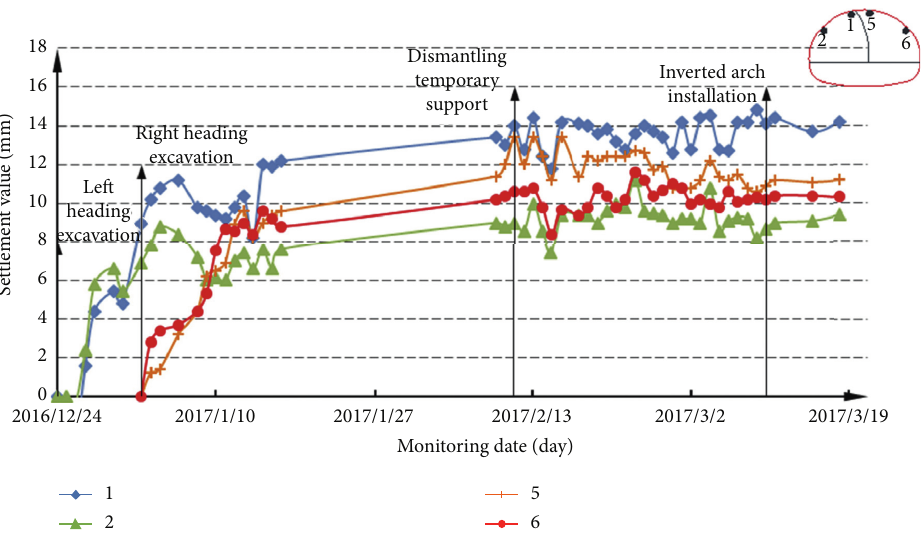
Figure 6: The temporal curve of the settlement of the crown at section YK2+ 449.